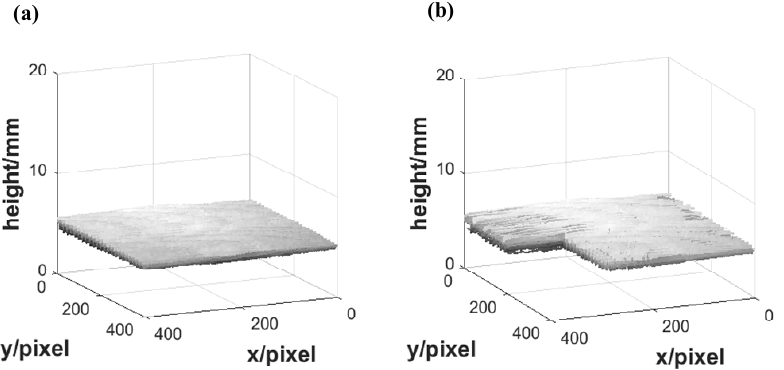
Figure 5. The height reconstruction of the plane: ( a ) using traditional Stoilov algorithm; ( b ) using improved Stoilov algorithm.